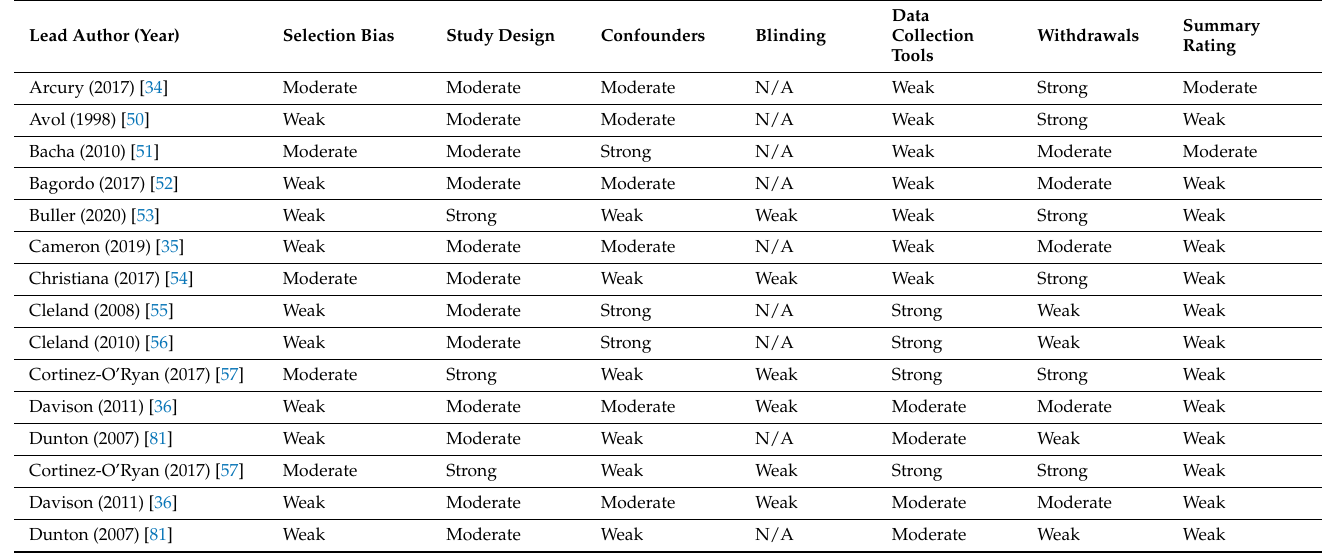
Table 5. Summary of the quality assessment using the Effective Public Health Practice Project Tool